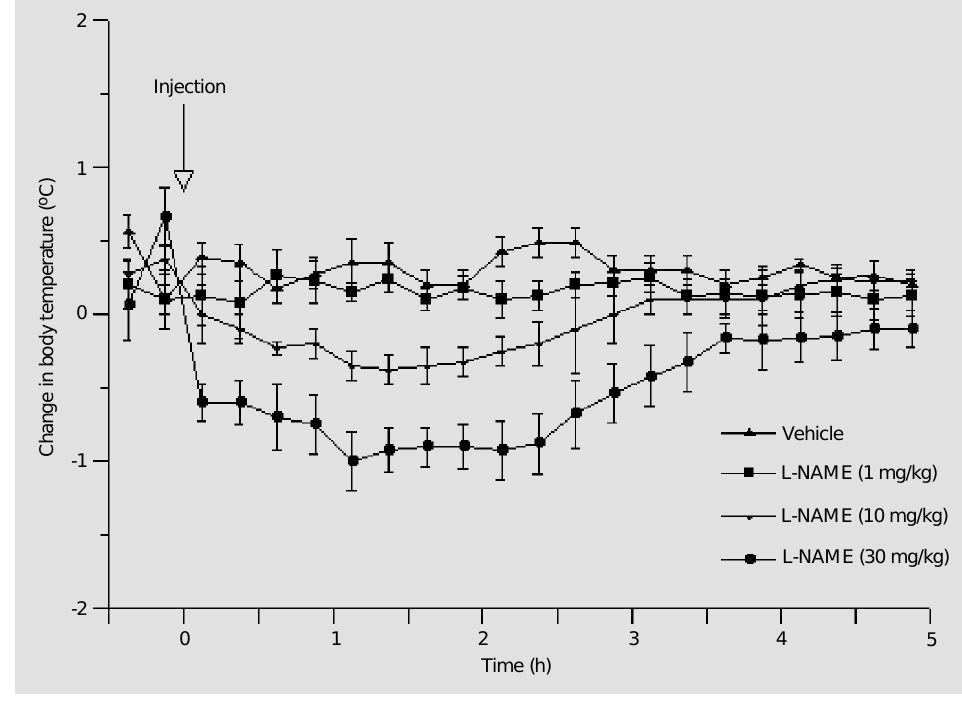
Figure 1 - Effect of intraperito- neal injection of N G -nitro-L-argi- nine methyl ester (L-NAME) on body temperature. Data are re- ported as mean changes in tem- perature (± SEM) determined at 15-min intervals relative to base- line. N = 5 in